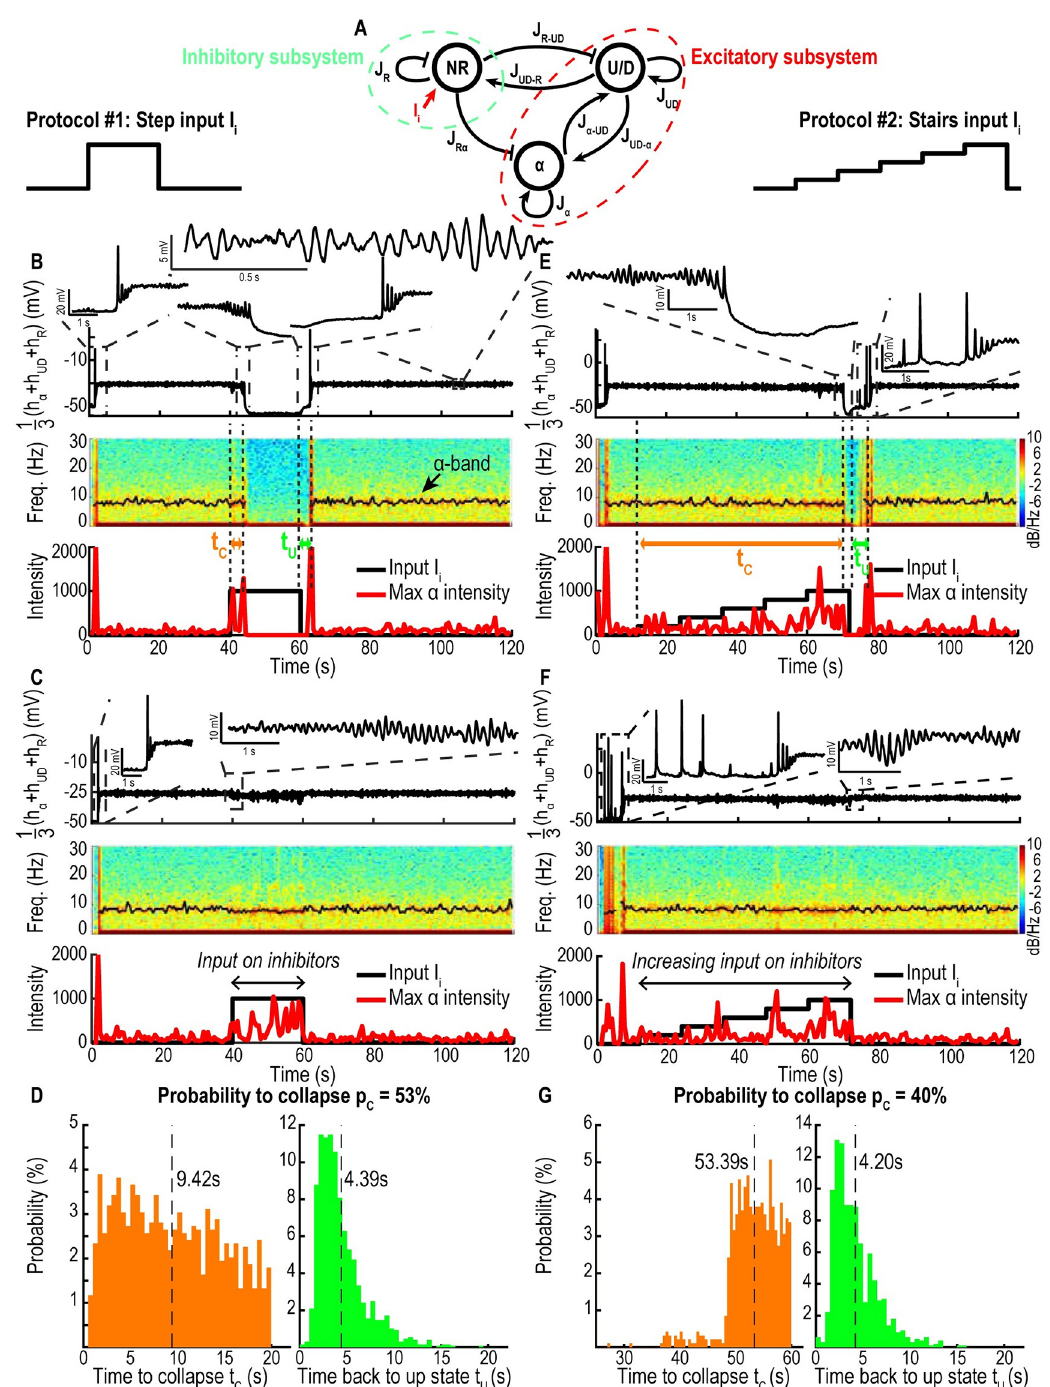
Fig 7. Cases of collapse of the α -band. A: Schematic of connectivity between the two excitatory ( α and U / D ) and inhibitory ( NR ) networks. B-C: Time-series of the sum of the three populations voltage h α + h + h (upper), spectrogram (center) with position UD R of maximum of the α -band (black, collapsing (B) and persistent (C)), maximum value of α intensity (red) and input I i (black, lower) for a step input. D: Distributions of the delay t between the beginning of stimulation and the collapse (orange) and delay C between the end of the stimulation and the moment the reapparition of the α -band (green). E-G: Same as B-D for a stairs input. Timescales for U / D , α and NR : τ = 0.005s, τ = 0.1s, τ = 0.06s. r f